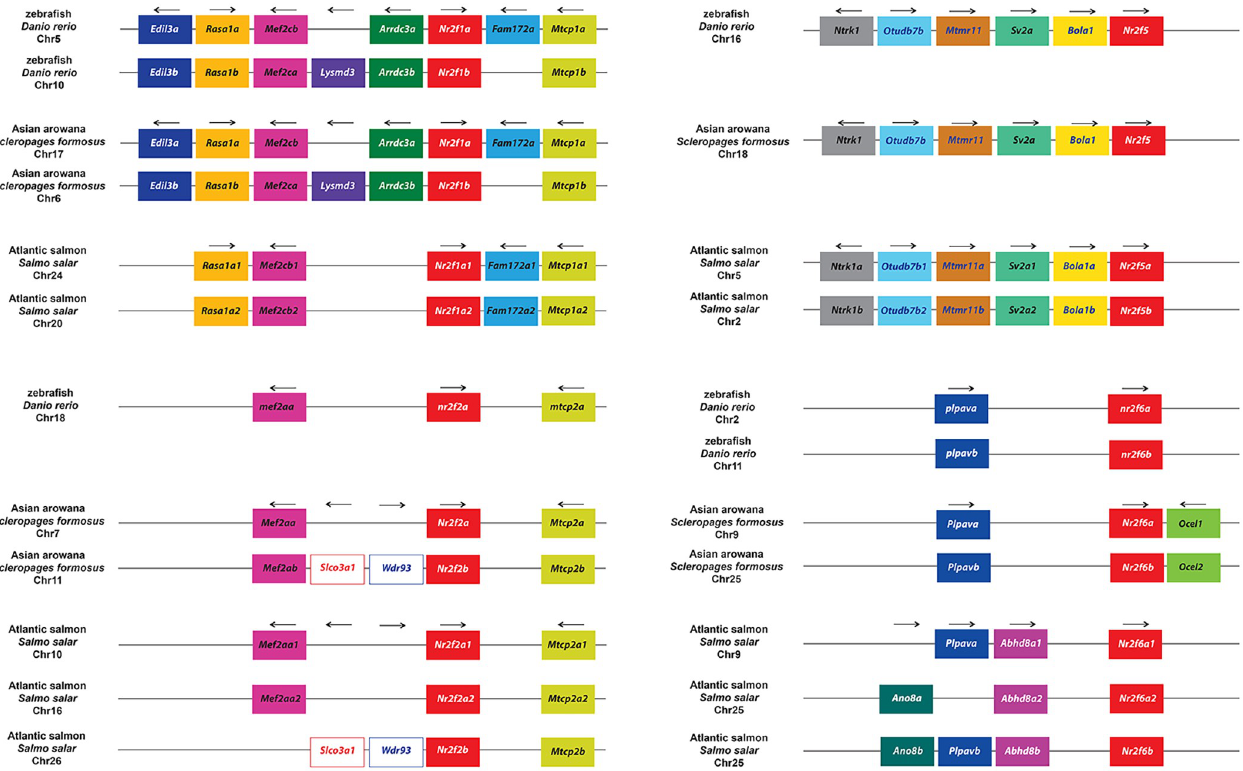
Fig 9. Synteny analysis of Nr2f genes in teleosts. Comparison of Nr2f genome environments in selected teleosts (zebrafish, Asian arowana, Atlantic salmon) with relative chromosomes/scaffolds. Rectangles of the same color represent flanking orthologous genes. Arrows indicate transcription orientation.